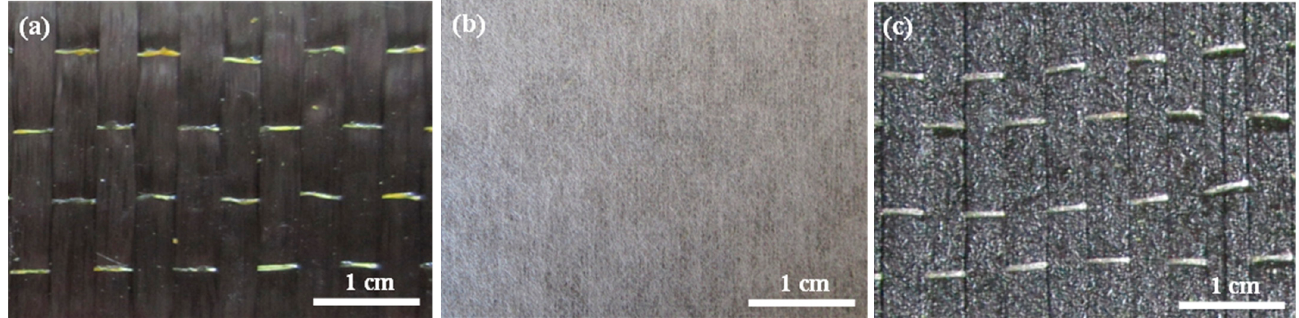
Figure 1. Metallograph of unidirectional carbon fabric and toughening agents. ( a ) Unidirectional carbon fabric; ( b ) nonwoven fabric; ( c ) dot matrix structure.